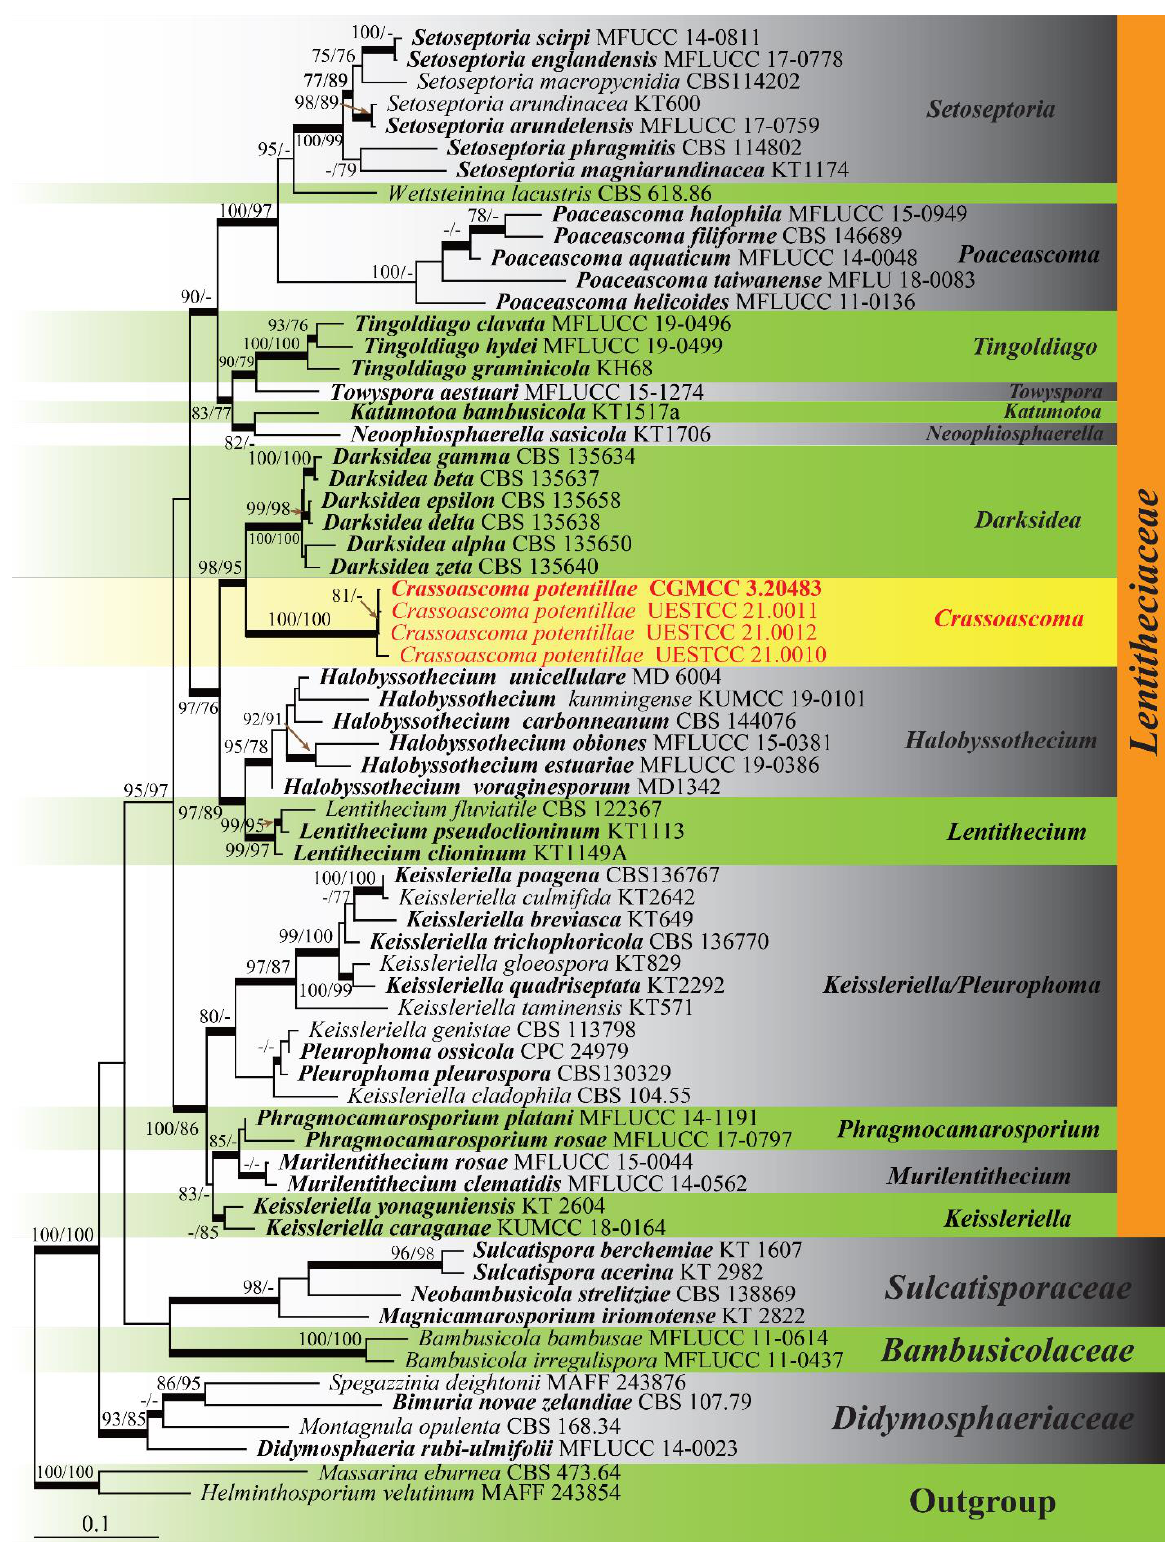
Figure 1. RAxML analysis of Lentitheciaceae and representatives in Massarineae based on combined SSU ITS, LSU, and TEF1- α sequence data. Bootstrap support values for maximum likelihood (ML) and maximum parsimony (MP) higher than 75% were placed above the branches (ML/MP). Bayesian posterior probabilities (BYPP) greater than 0.95 were shown as bold branches. Ex-type strains were in bold and new strains generated in this study were indicated in red.